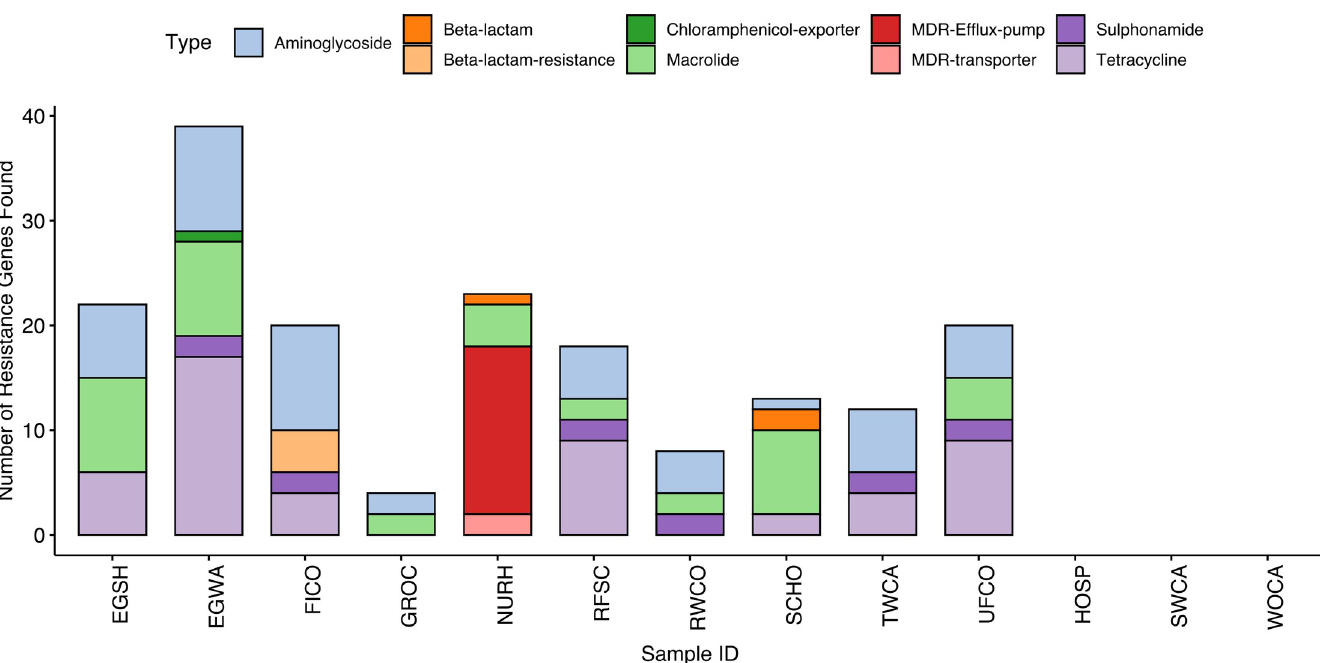
Fig 2. Bar chart of the total number of antibiotic resistance genes (ARGs) found by drug class and sample. In this instance, results for each duplicate were combined into a single bar.